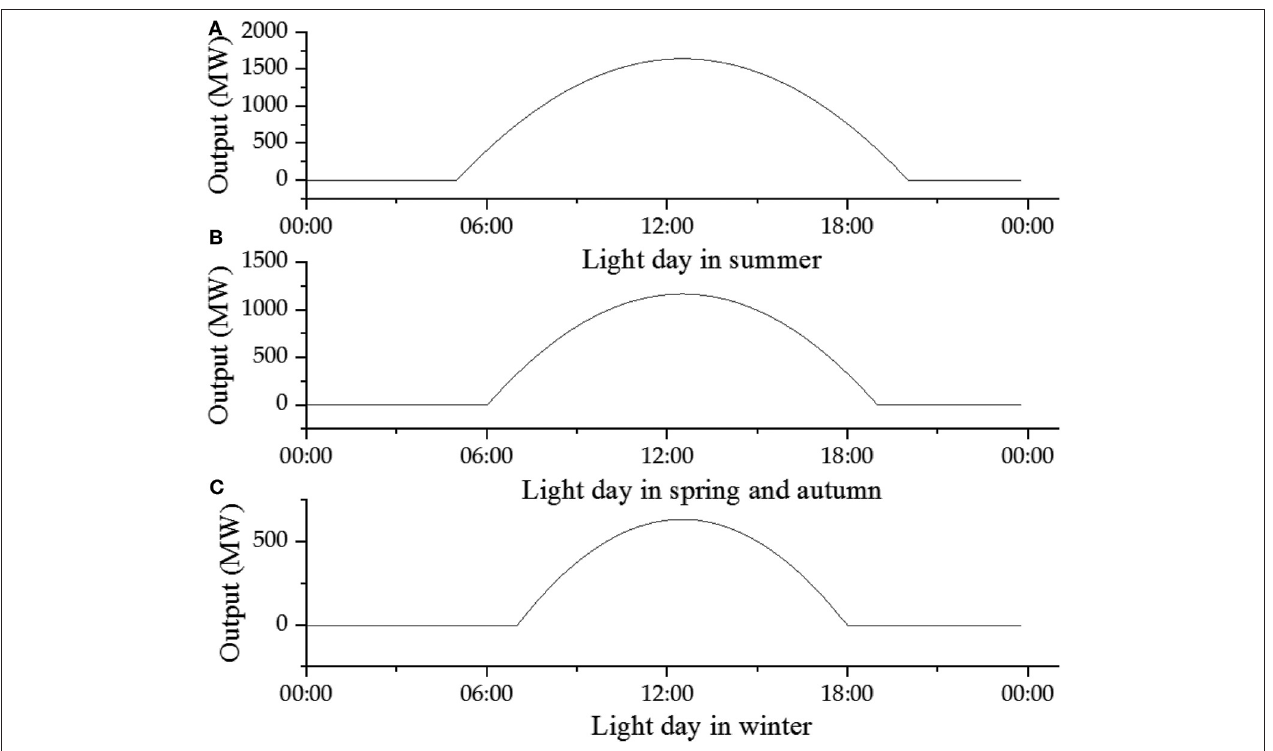
FIGURE 2 | Simulation curve of the solar typical daily output of Guangdong in